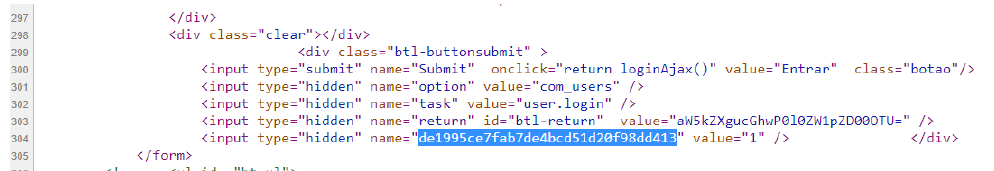
Figure 5. Source code of the page that results in the different hash values.